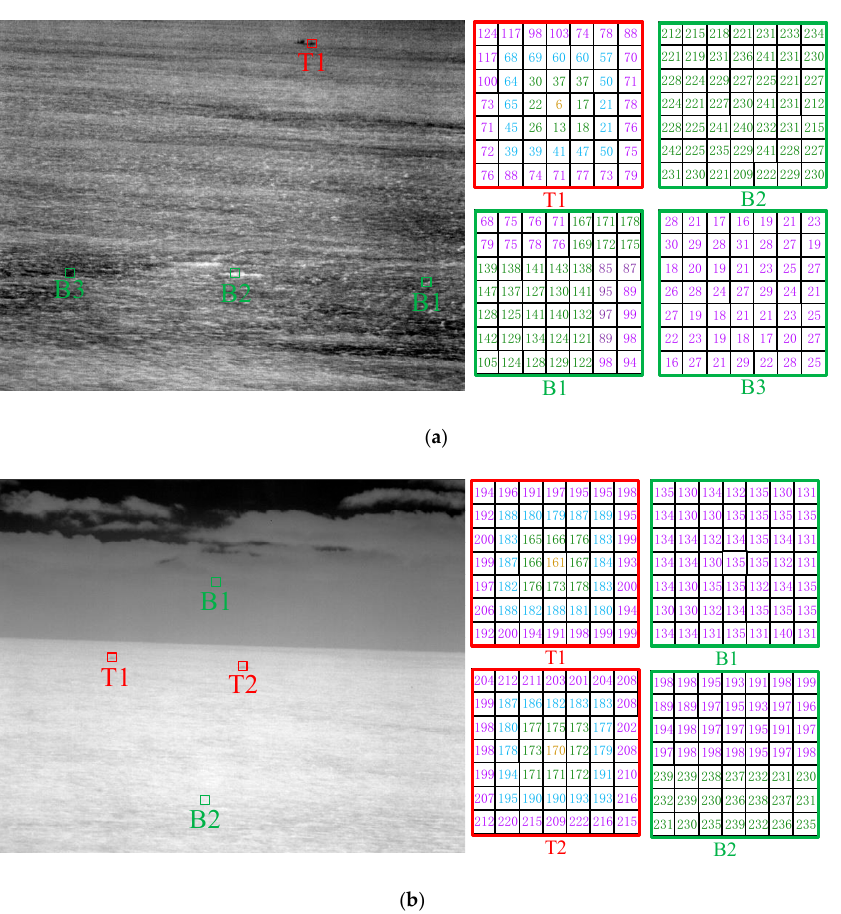
Figure 2. Analysis results of infrared small target block region and background patch region. ( a ) Typical image A infrared small target patch area and background patch area. ( b ) Typical image B infrared small target patch area and background patch area. designed, the IGD preprocessing method is shown in Equation (1), 𝜎 (cid:2869) and 𝜎 (cid:2870) indicates the high-scale and low-scale filter parameters.